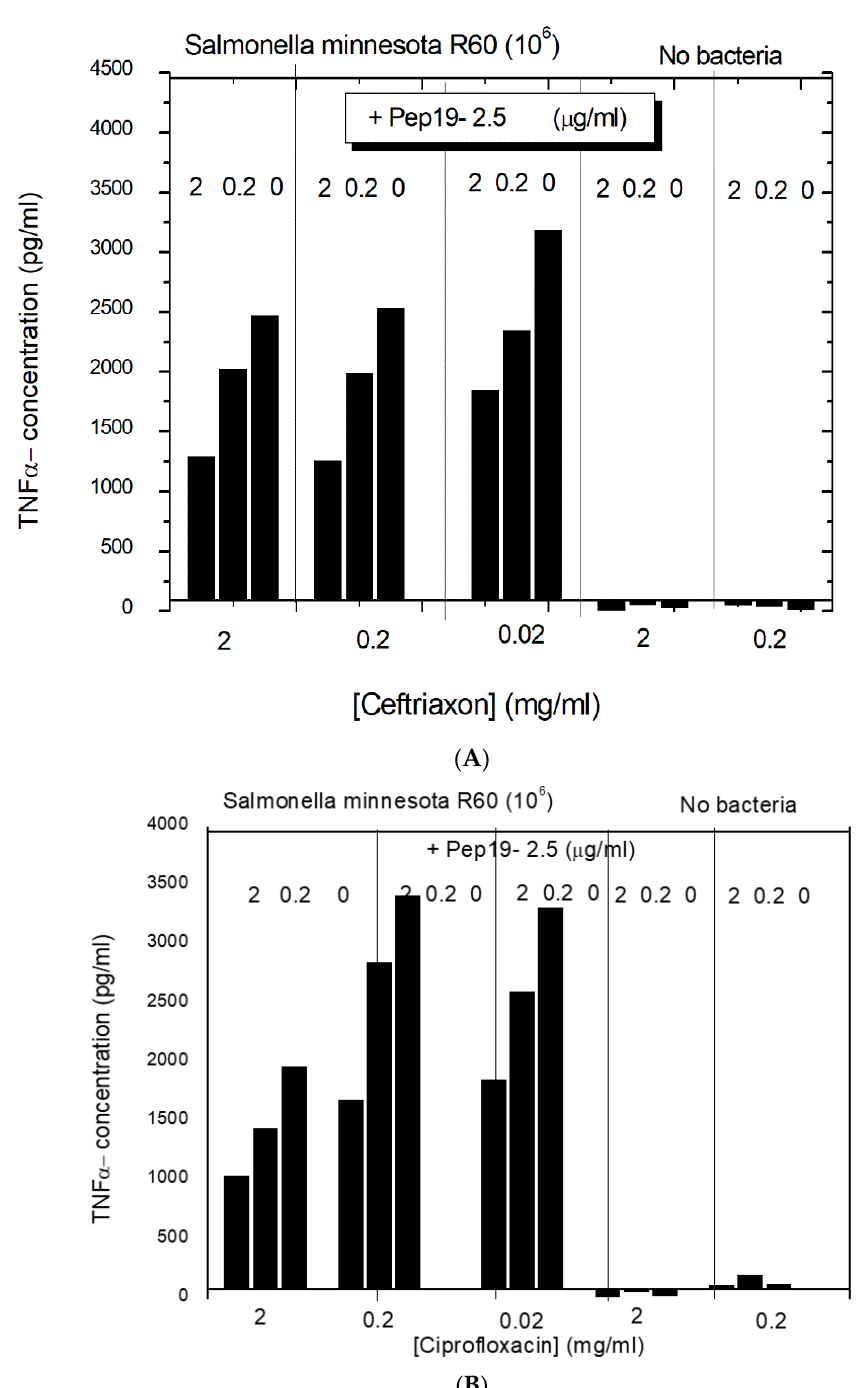
Figure 5. Secretion of the cytokine tumor necrosis factor α (TNF α ) by human mononuclear cells exposed to bacteria from Salmonella minnesota strain R60 and in the presence of ceftriaxone ( A ) and ciprofloxacin ( B ) and Pep19-2.5. Mean values and standard deviations due to the determination of TNF α in